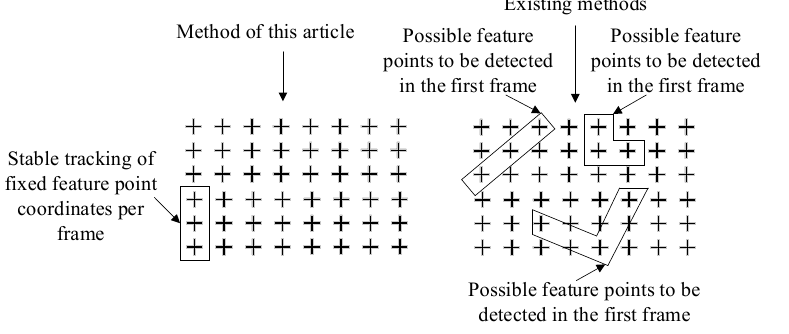
Figure 4. Schematic diagram of feature point detection between different frames.